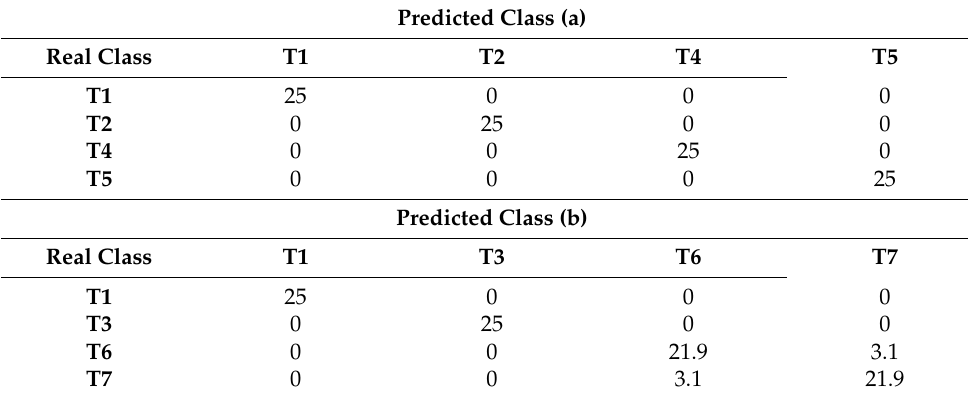
Table 5. Confusion matrix obtained through PLS-DA for discrimination between Californian-style black olives prepared with fresh (a) and lyophilized (b) Carao and stuffed with flavoured